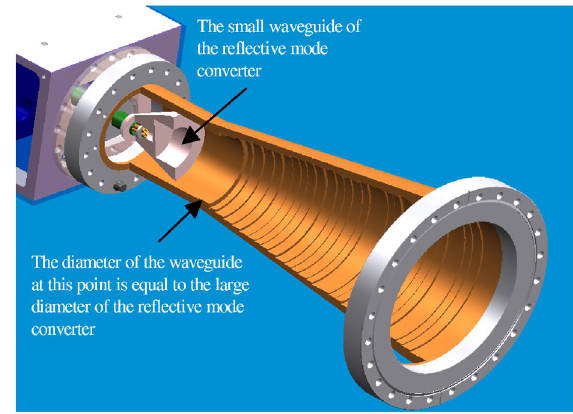
FIG. 6. (Color) The simulated frequency response of the input mode into the TE 01 02